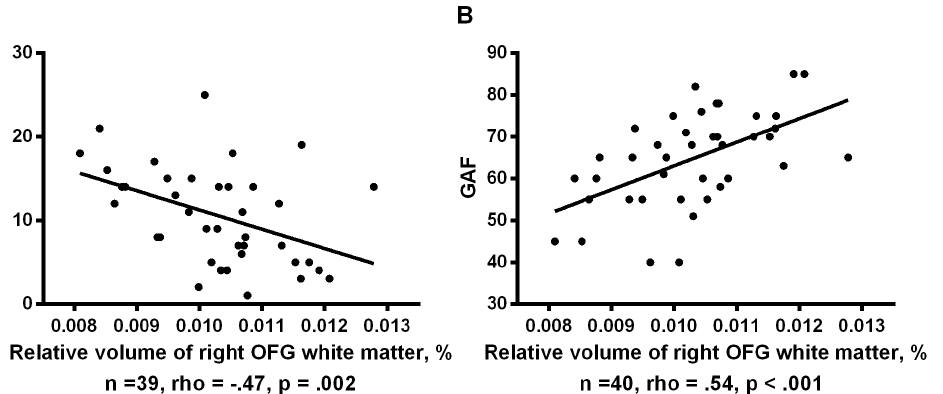
Figure 2. Relationships between white matter volumes of the right OFG and scores of PDSS and GAF in the patients with panic disorder. The white matter volume of the cluster in the right OFG was significantly negatively related to total PDSS scores in the patients with panic disorder (rho= 2 .47, p=.002) (A). The white matter volume of the cluster was also significantly positively related with GAF scores in the patients with panic disorder (rho=.54, p , .001)